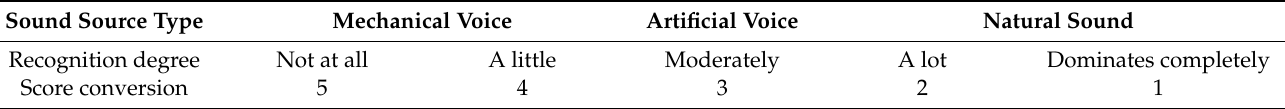
Table 2. Sound source identification in open-plan studio environment.